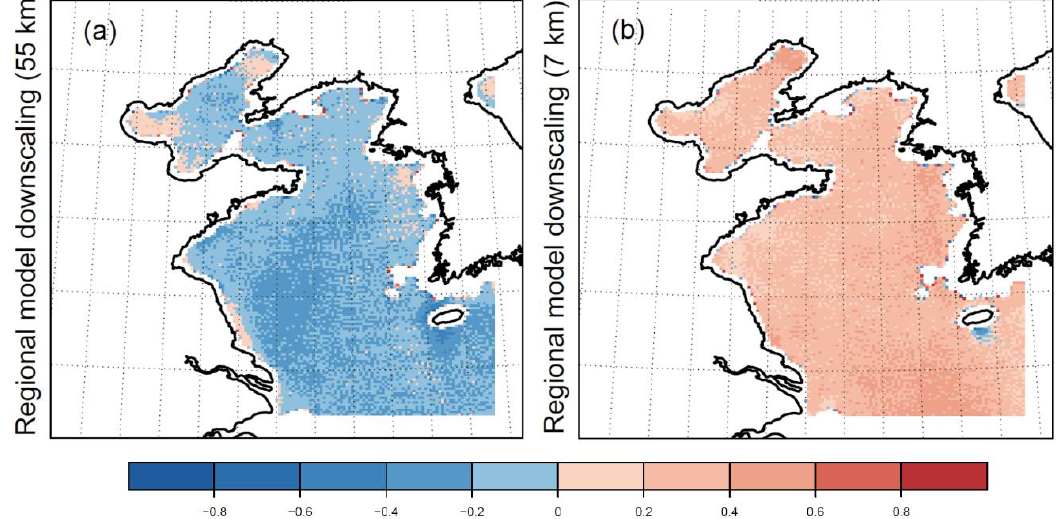
Figure 7. Brier Skill Scores (red: improvements; blue: no improvement) of a regional hindcast using: ( a ) 55 km grid resolution; ( b ) 7 km grid resolution with the constrained global model over the period of December 1999 – November 2009 for marine surface wind speeds of 3 – 25 m/s relative to observational reference data (“truth”) QuikSCAT [57], © Copyright 2017 AGU.